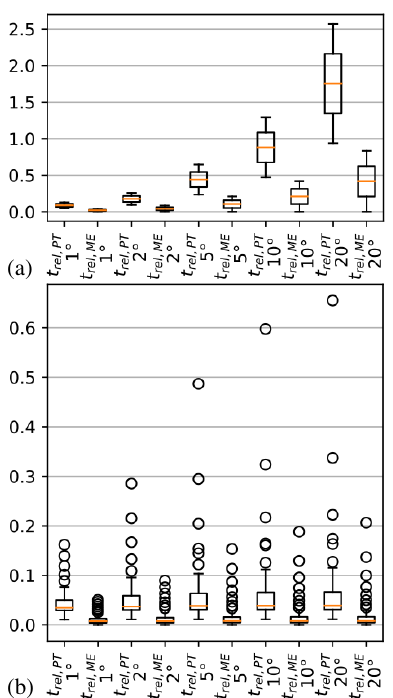
Figure 7. (a) Boxplots of absolute errors (without dimension); (b) boxplots of relative errors for different relative rotation angles.